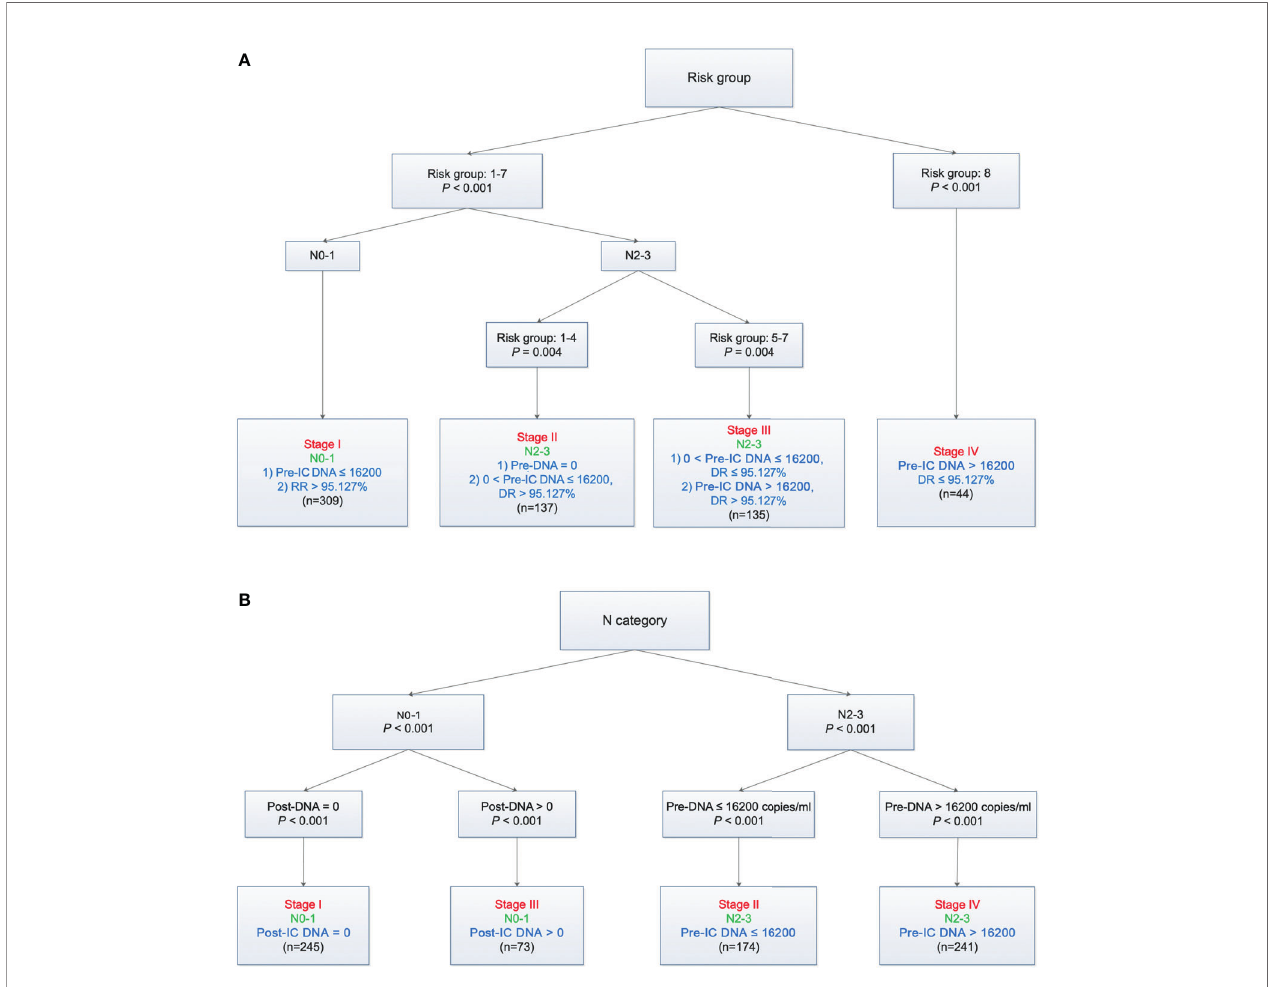
FIGURE 3 | Recursive partitioning analysis to create new staging system after combining decrease rate (A) or post-IC DNA (B) with pre-IC DNA and TNM staging. (A) RPA1 staging system; (B) RPA2 staging system. Pre-IC DNA, pre-treatment Epstein-Barr virus DNA; RR, decrease rate; Post-IC DNA, plasma Epstein-Barr virus DNA after induction